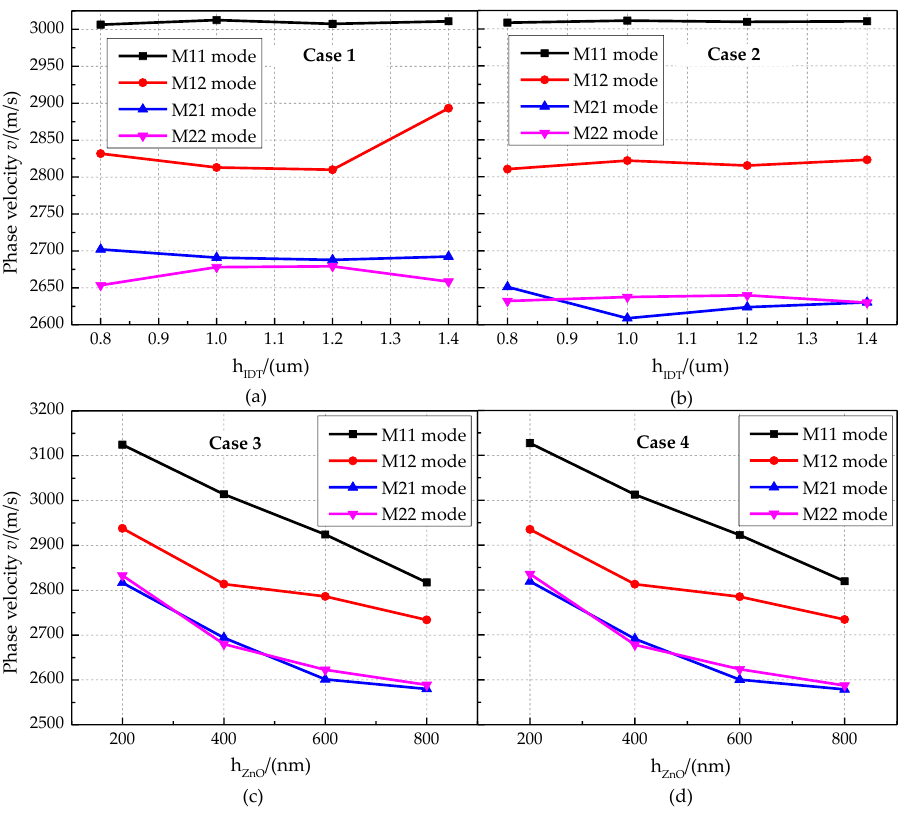
Figure 12. Phase velocity characteristics of the phonon piezoelectric device for different cases. ( a ) Case 1. ( b ) Case 2. ( c ) Case 3. ( d ) Case 4.